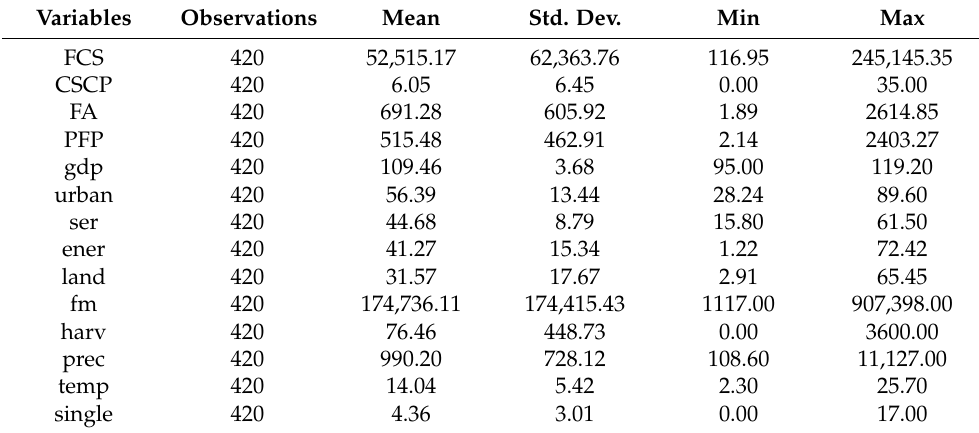
Table 1. Descriptive statistics of main